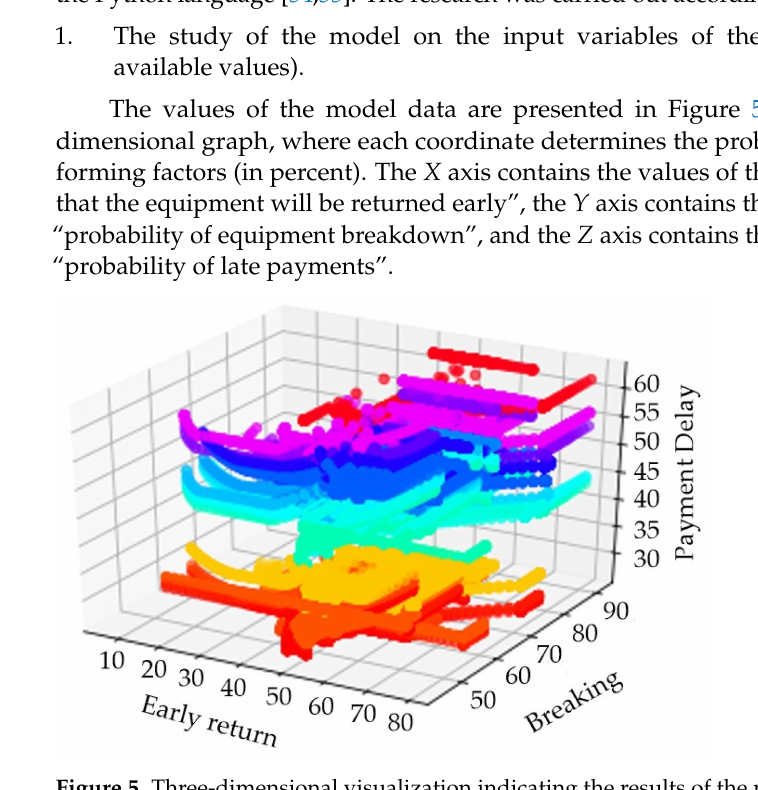
Figure 5. Three-dimensional visualization indicating the results of the